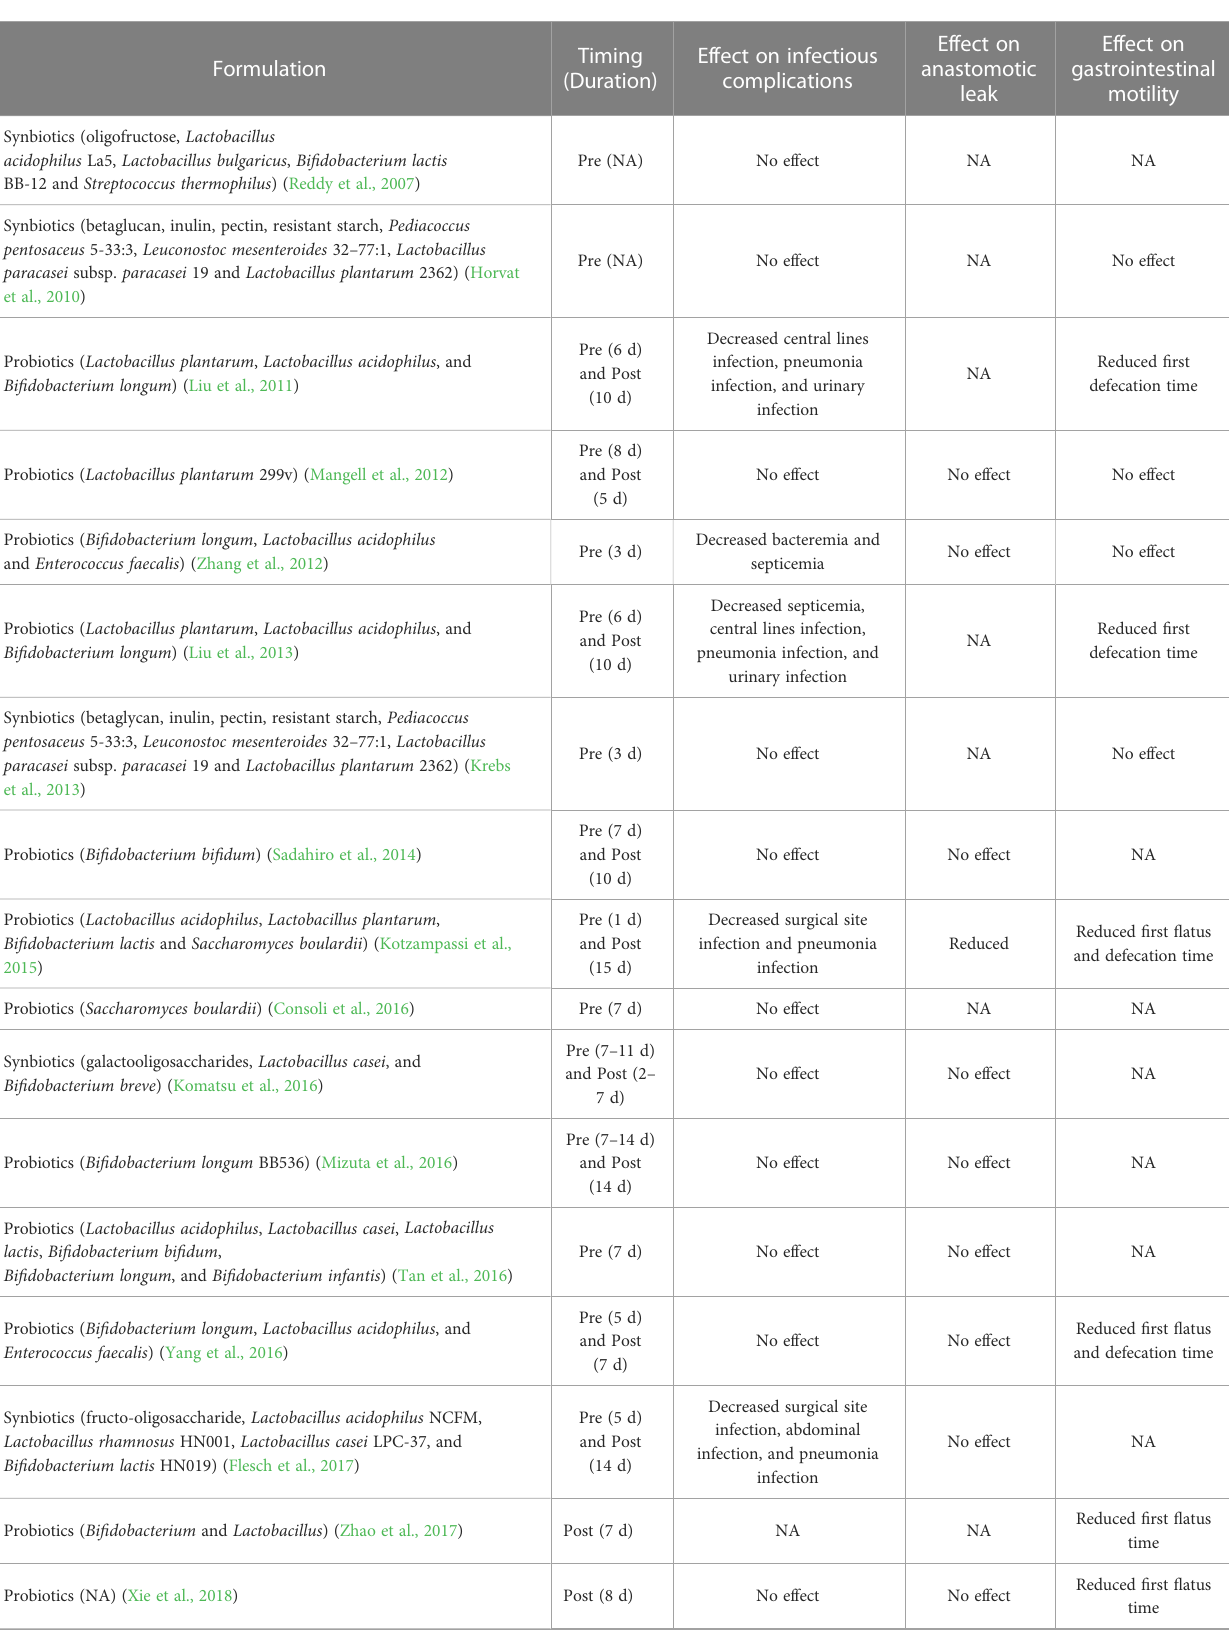
TABLE 1 Effect of synbiotics or probiotics on infectious complications, anastomotic leak, and gastrointestinal motility after gastrointestinal